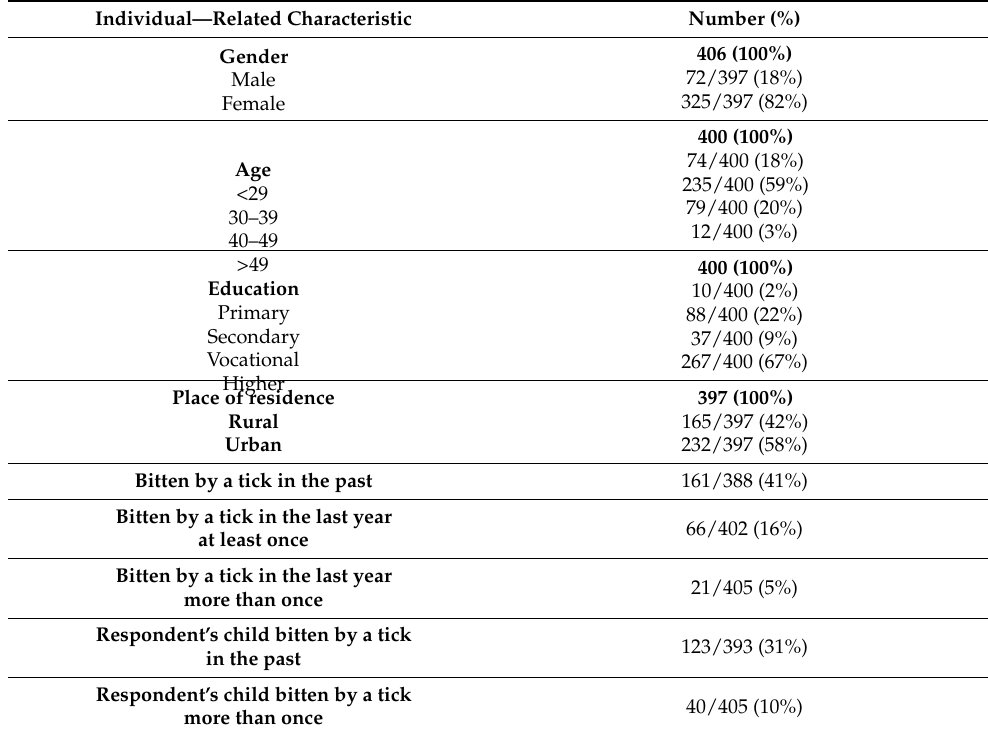
Table 1. Personal characteristics of the